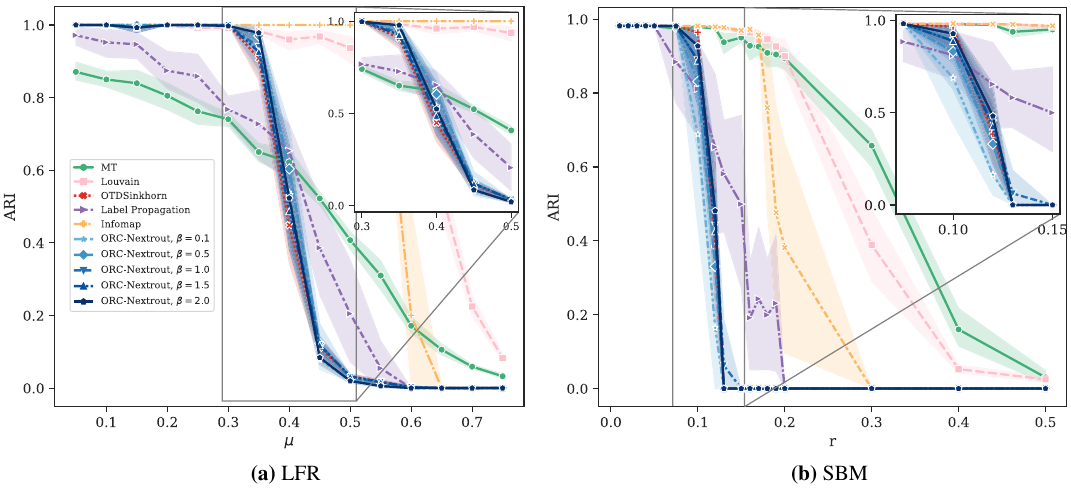
Figure 3. Results on LFR and SBM synthetic data. Performance in detecting ground-truth communities is measured by the ARI score. Markers and shadows are the averages and standard deviations over 10 network realisations with the same value of the parameter used in generation. Markers’ shape denote different algorithms. ( a ) LFR graph with N = 500 nodes and different values of K ranging from (17, 22). ( b ) SBM with N = 500 nodes, K = 3 communities and average degree d = 15 . The parameter r is the ratio of inter- community with intra-community edges. The inset on each plot zooms in the central parts of the